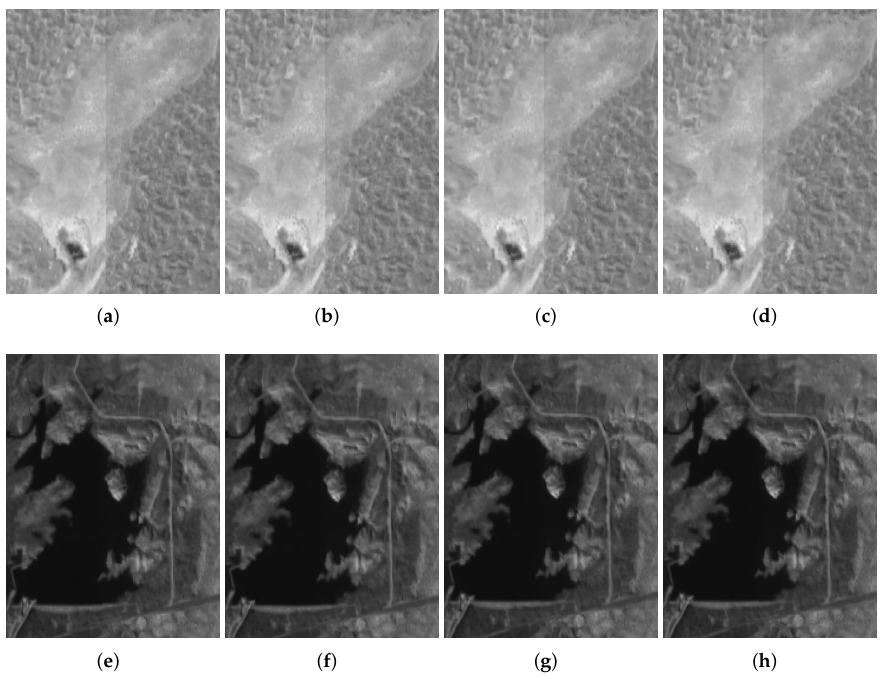
Figure 14. Stitching results for Image Data 3 with different methods: ( a ) traditional line-time nor- malization, ( b ) line-based line-time normalization, ( c ) block-based line-time normalization, ( d ) scene- based line-time normalization, ( e ) traditional line-time normalization, ( f ) line-based line-time normal- ization, ( g ) block-based line-time normalization, ( h ) scene-based line-time normalization.